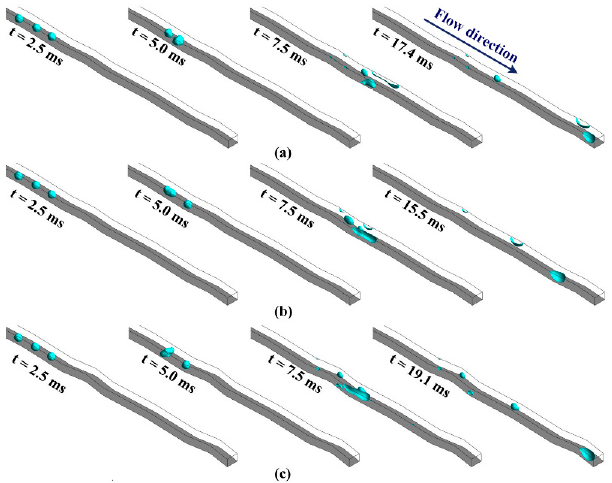
Figure 8. Temporal droplet flows for multiple droplets (r = 200 µ m) in: ( a ) Design 1; ( b ) Design 2; and ( c ) Design 3 channels at an inlet velocity of 10 ms − 1 and contact angles θ GDL = 120°, θ side; top = 82°; 82° respectively.